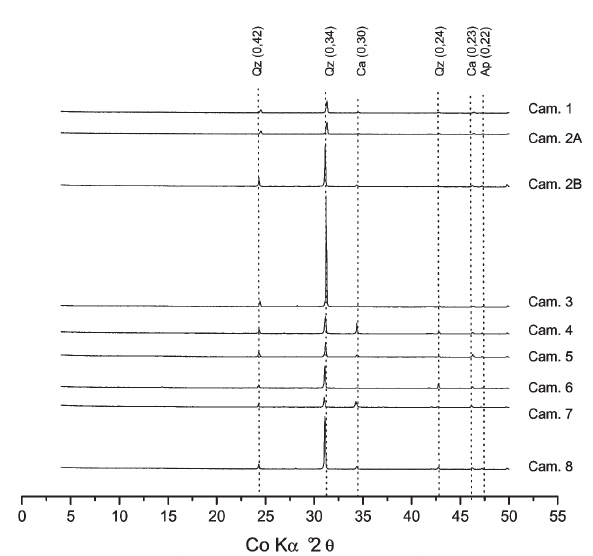
Figura 6. Difratogramas de raios-X da fração areia do solo da Lapa do Boquete. Qz: quartzo; Ct: caulinita; Ca: calcita; e Ap: apatita.